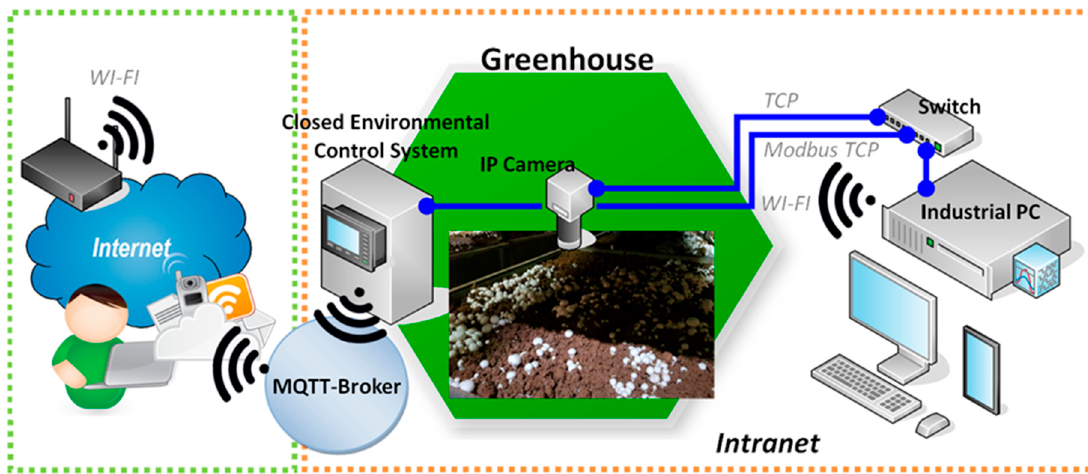
Figure 3. The communication structure of the mushroom measurement system.